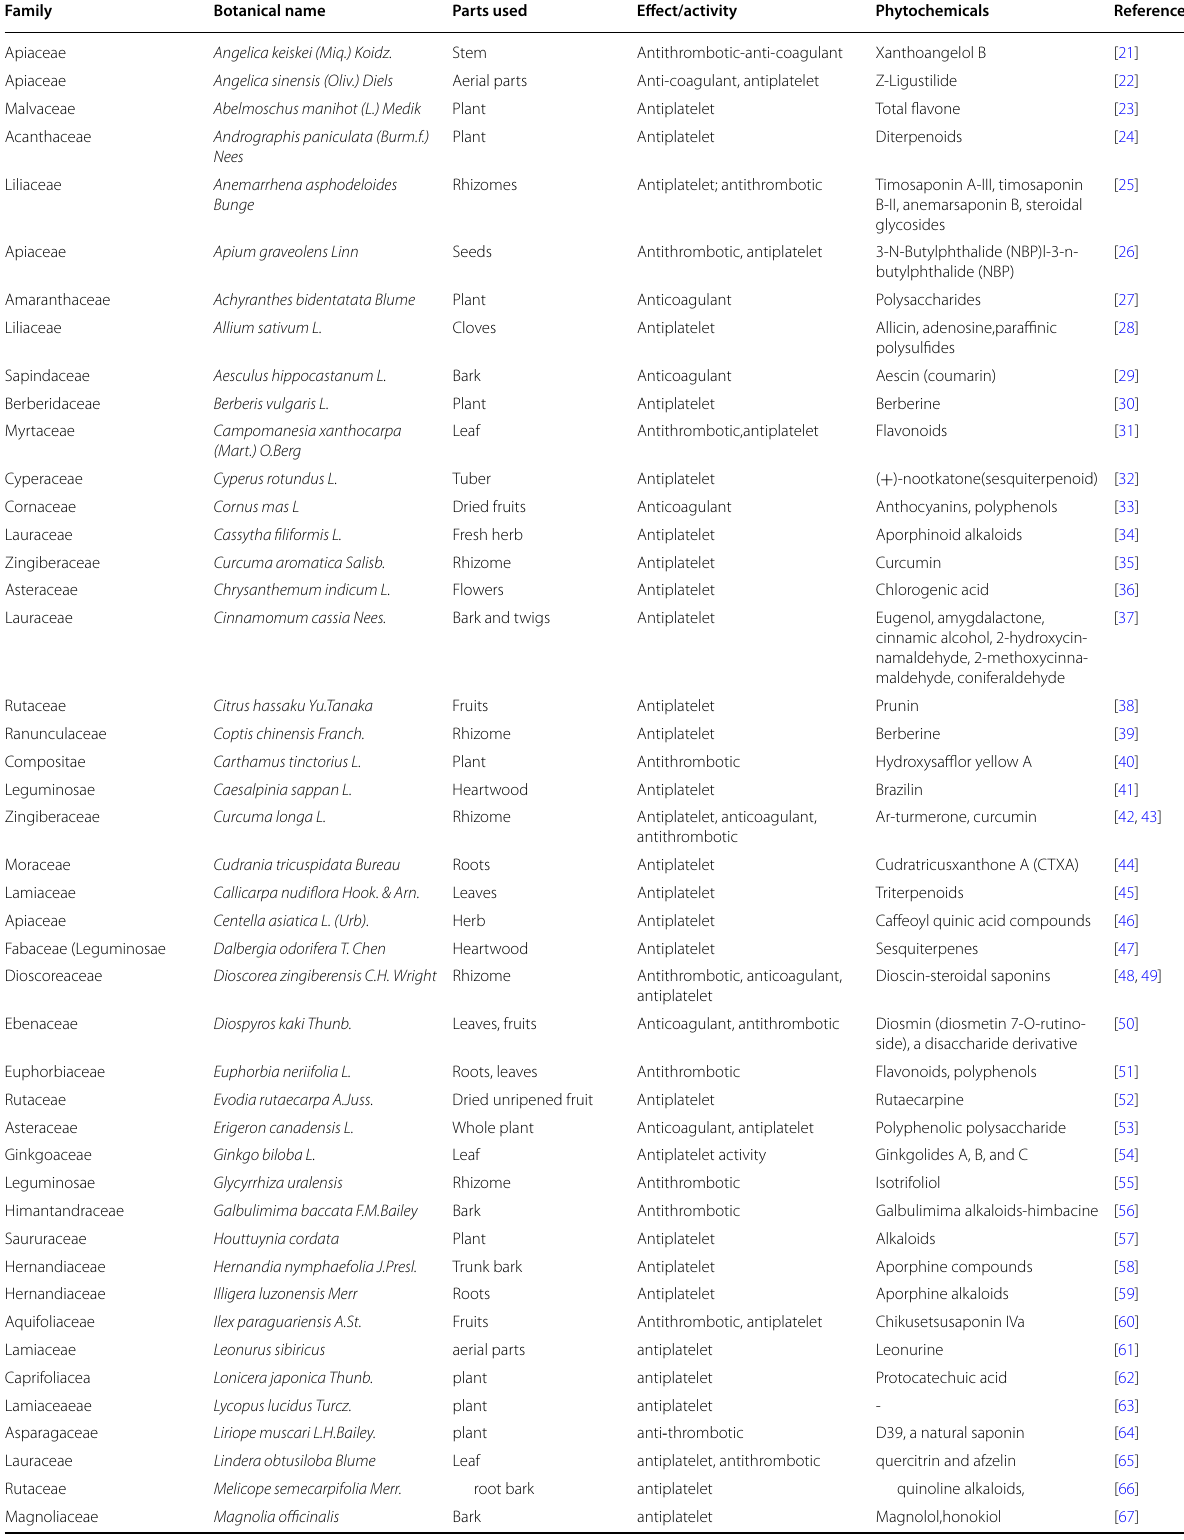
Table 1 List of herbal sources of antithrombotic and its phytoconstituents